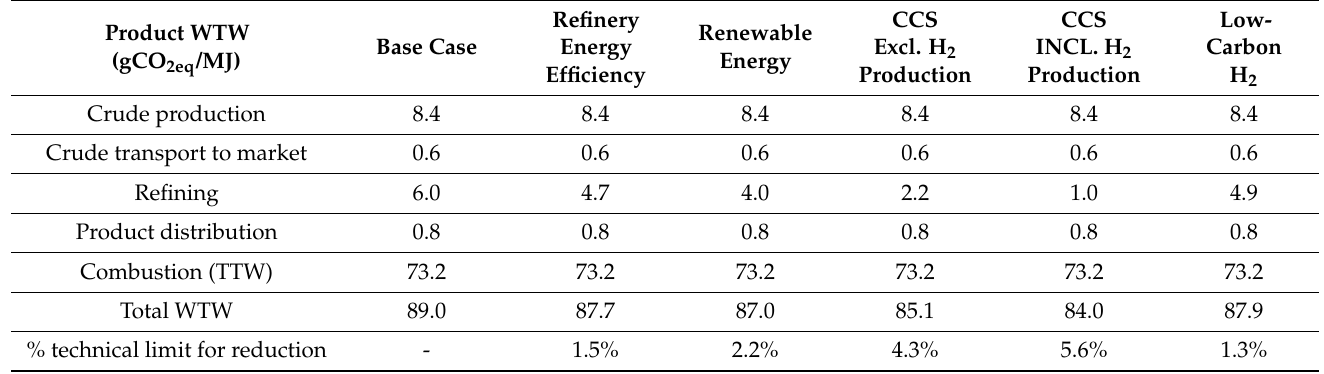
Table 5. Summary of the impact of general refinery GHG reduction levers on jet WTW emissions.